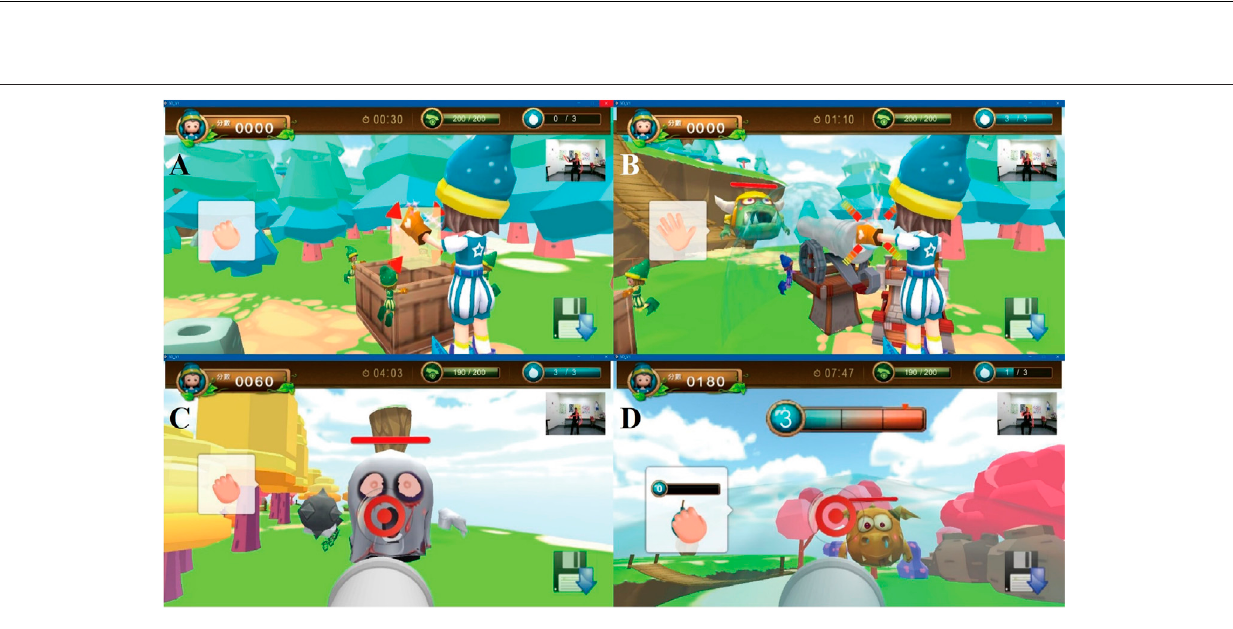
FIGURE 2 | A Kinect-based CIT program was designed with three levels of task dif fi culty. In the preparation stage (A) and the fi rst level (B) , the movement training goalsincludereaching,grasping,andreleasing.Inthesecondlevel (C) ,thetraininggoalsincludereaching,grasping,releasing,andaiming.Inthethirdlevel (D) ,thegoals consist of reaching, grasping, releasing, aiming, and